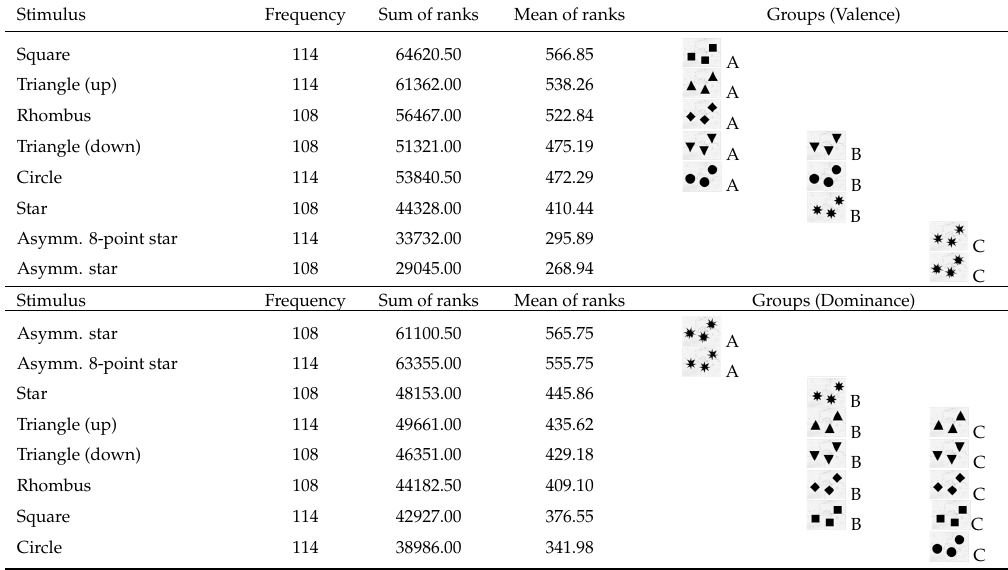
Table 4. Results of multiple pairwise comparisons of map stimulus set 2 indicating groups of similar valence and dominance.